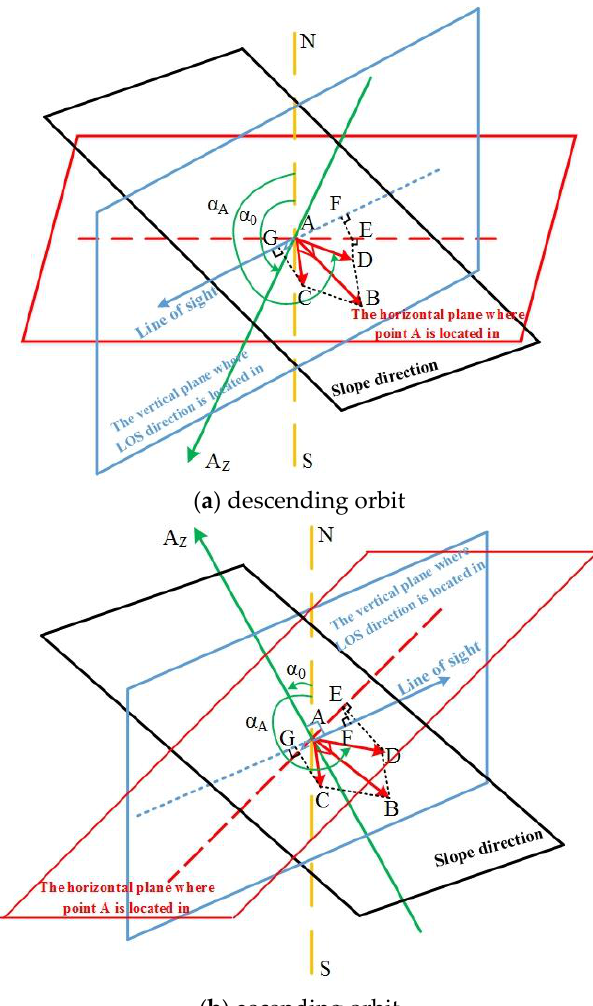
Figure 1. Geometric relationship between slope displacement and displacement in line-of-sight (LOS) in descending ( a ) and ascending ( b ) orbits.